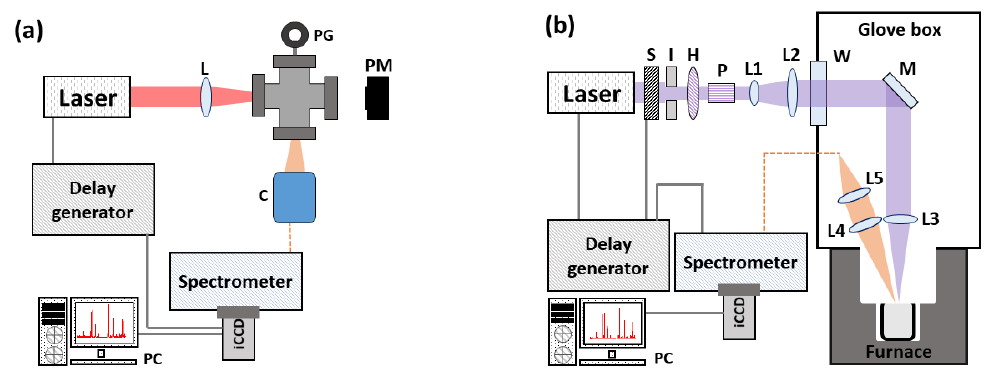
Figure 2. Set-up for ( a ) the Xe in He and ( b ) the Eu in LiCl-KCl LIBS measurements [5]. L = lens, PG = pressure gauge, PM = power meter, C = collimator, S = optical shutter, I = iris diaphragms, H = half-wave plate, P = polarizer, W = window, and M = laser line